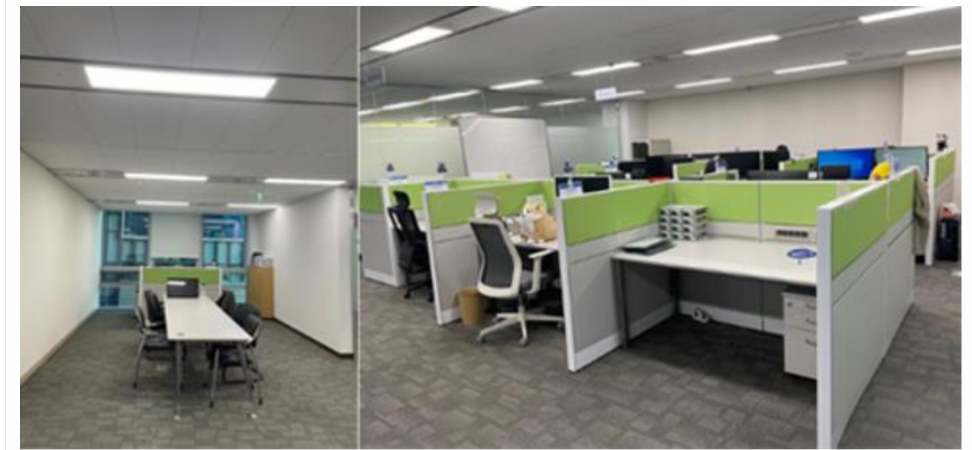
Figure 8. Indoor environment for mobile SLAM system evaluation.